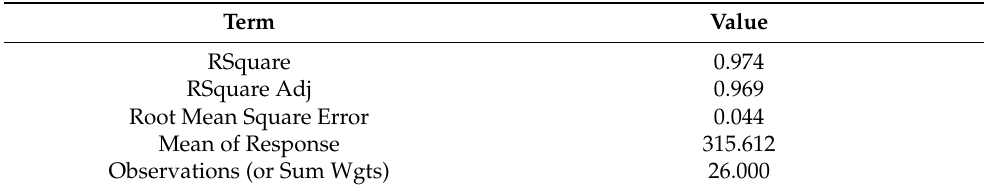
Table 9. Suitability of the used model.